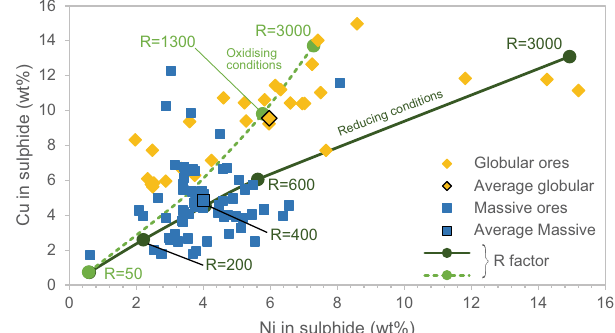
Fig. 7 Ni and Cu contents of globular and massive sulphide ores in Noril ’ sk-Talnakh intrusions. Data for globular sulphides (in yellow) are recalculated to 100% sulphide and are from ref. 2 ; the average of 30 analyses is shown. Data for massive sulphides (in blue) are from refs. 2, 43 ; the average of 64 analyses is shown. The solid and the dotted lines indicate equilibrium contents for variable silicate/sulphide mass ratios, i.e., R (indicated on the lines), calculated following Campbell and Naldrett ’ s equation 9 using Dsulf/sil values determined in this study for the most reducing and the most oxidising redox conditions (Table 1), and initial Ni and Cu concentration in the parental magma of 120ppm and 150ppm,